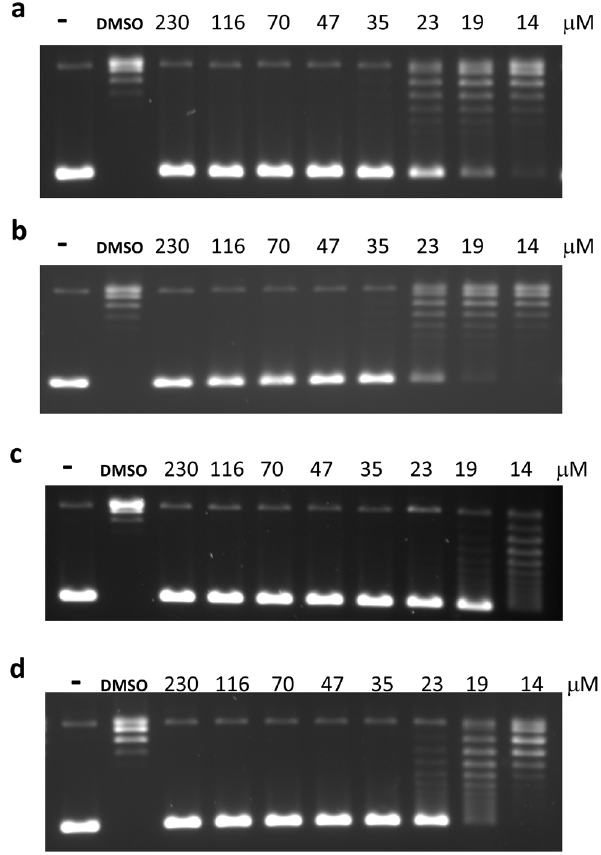
Figure 4. Inhibition of Relaxation activity of E.coli topoisom- erase I by anziaic acid. Assay was carried out in the presence of DMSO or the indicated concentration of anziaic acid with (a) 0.5 mM MgCl 2 , (b) 0.5 mM MgCl 2 + 0.0025% Tween 20, (c) 6 mM MgCl 2 , (d) 6 mM